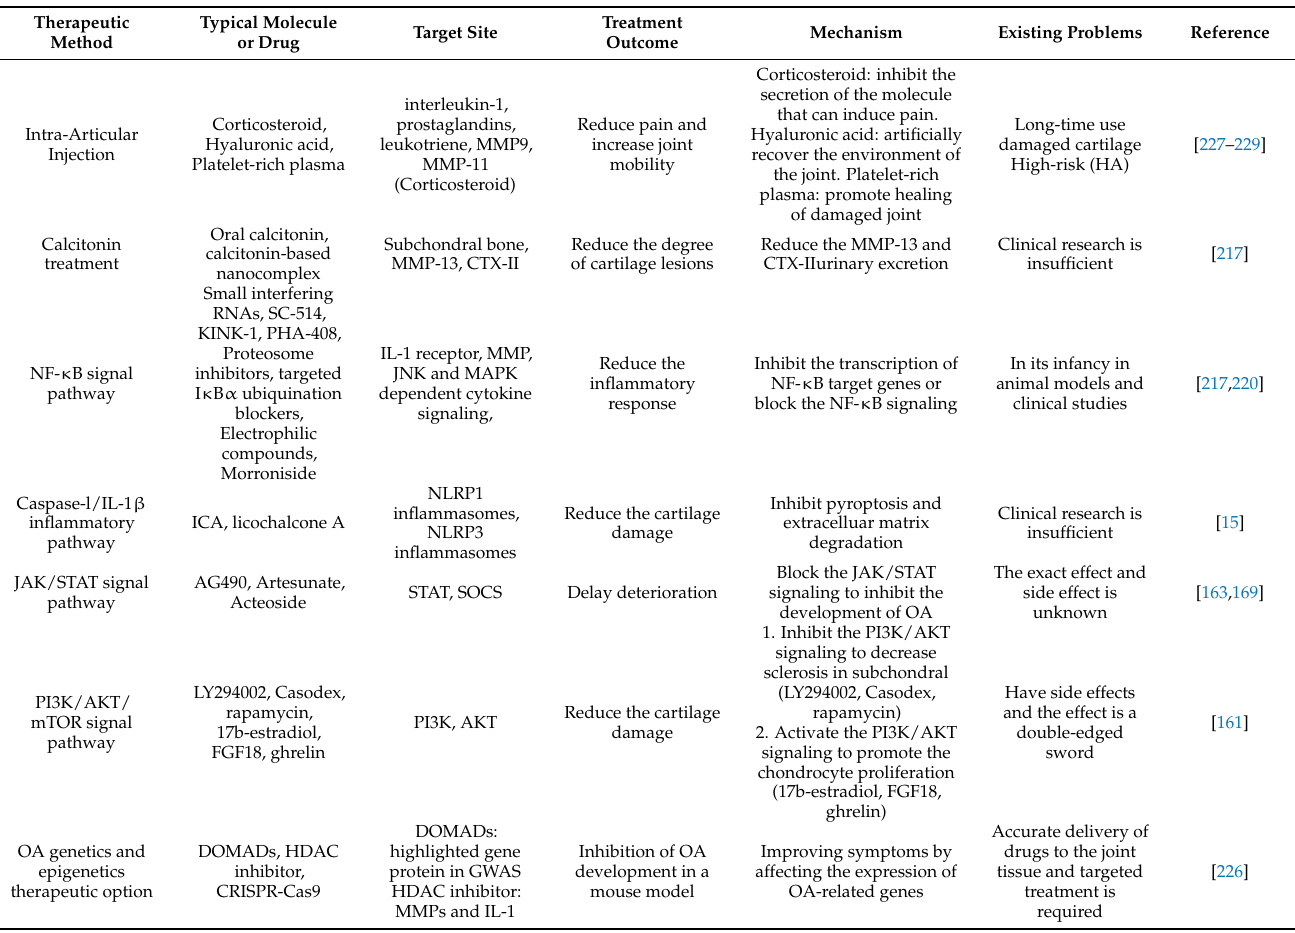
Table 1. The different therapeutic methods of